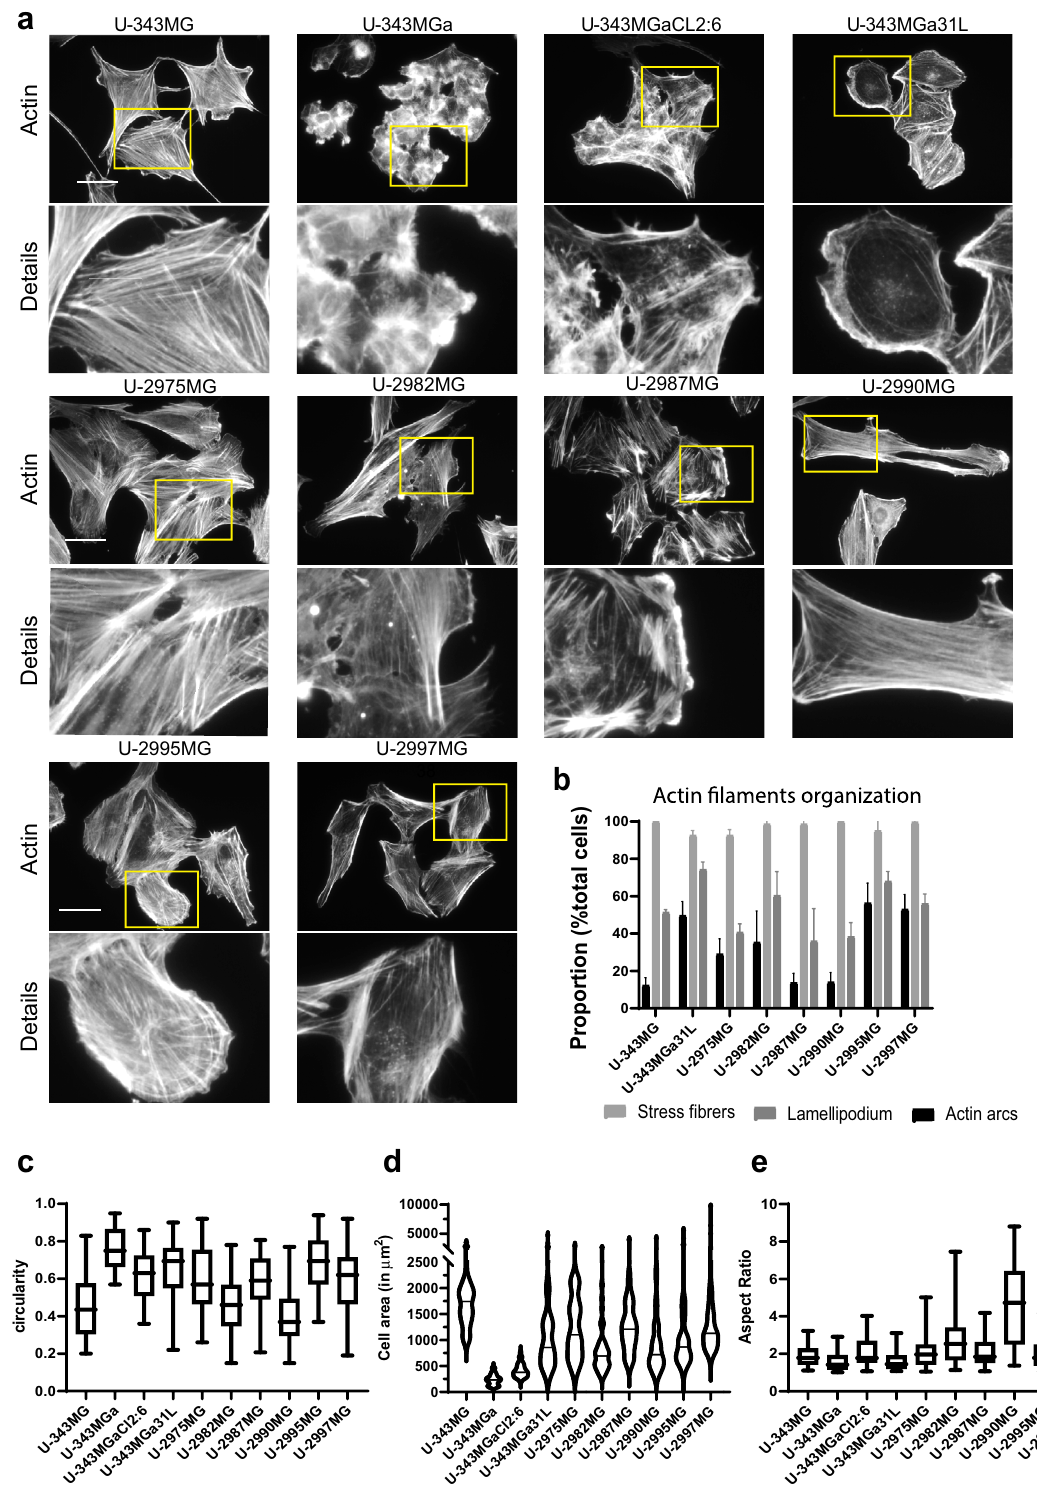
Figure 1. Actin filament organization and cell morphology. ( a ) Representative images of actin filament organization visualized by TRITC-conjugated phalloidin. Scale bar, 50 µm. ( b ) Analysis of the type of actin filament organization in each cell line. Quantification was performed from three independent experiments per cell line. Statistical significance was calculated with ANOVA-Tukey’s post-hoc tests and summarized in Supplementary Table S1. ( c–e ). Quantification of circularity ( c ), cell area ( d ), and aspect ratio ( e ) using ImageJ (n = 50 for each cell line). Statistical significance was calculated with ANOVA-Tukey’s post-hoc tests and summarized in Supplementary Table